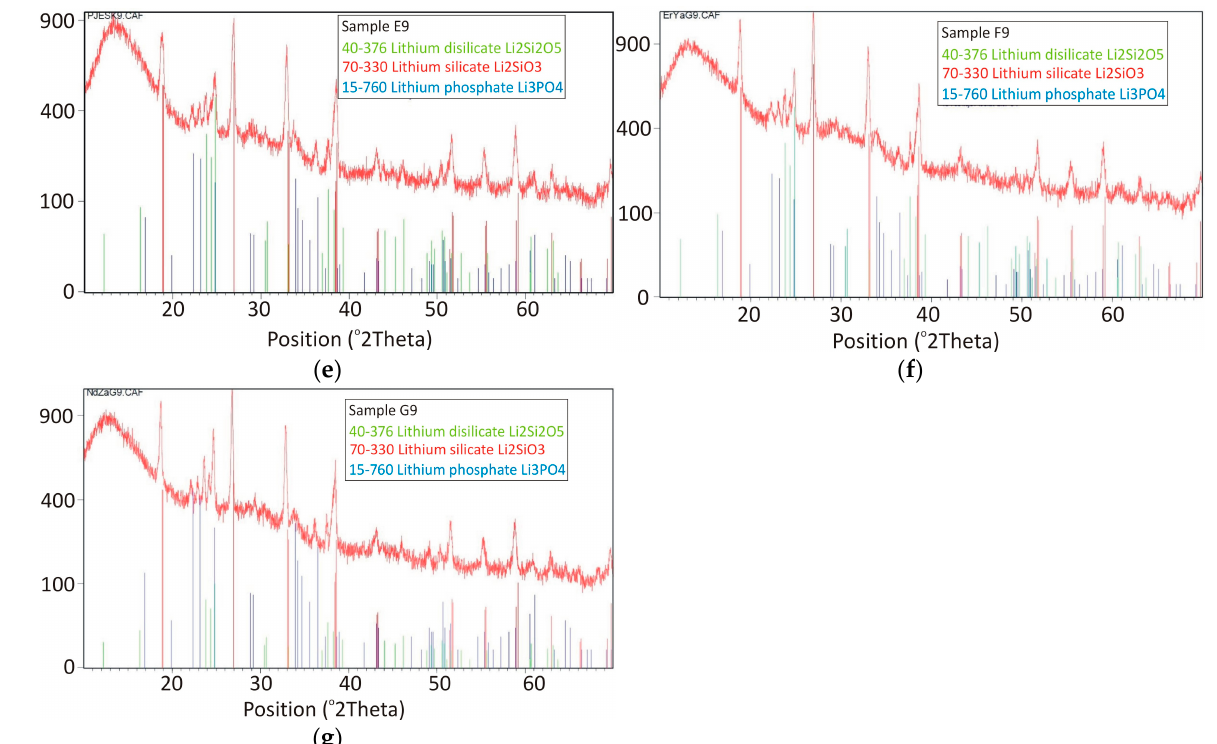
Figure 6. Graphical presentation of the X-ray diffraction analysis: ( a ) Group A; ( b ) Group B; ( c ) Group C; ( d ) Group D; ( e ) Group E; ( f ) Group F; ( g ) Group G.